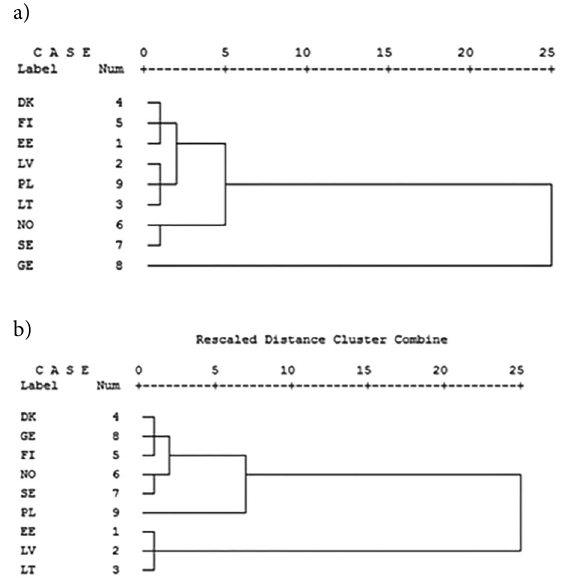
Fig. 14. Dendrograms for the cargo handled in the BSR countries by railway, maritime and road transport in 2012 (a) and LPI